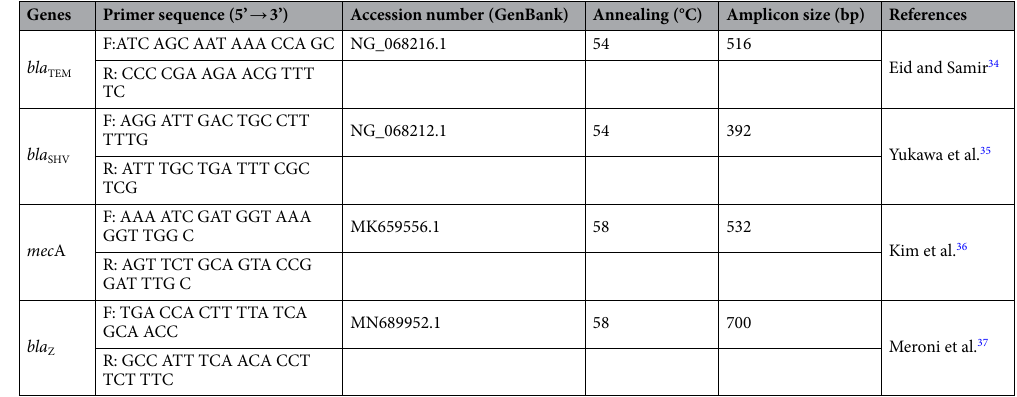
Table 1. PCR sets used for detection of target antibiotic-resistance genes in the selected foodborne bacterial isolated from bovine